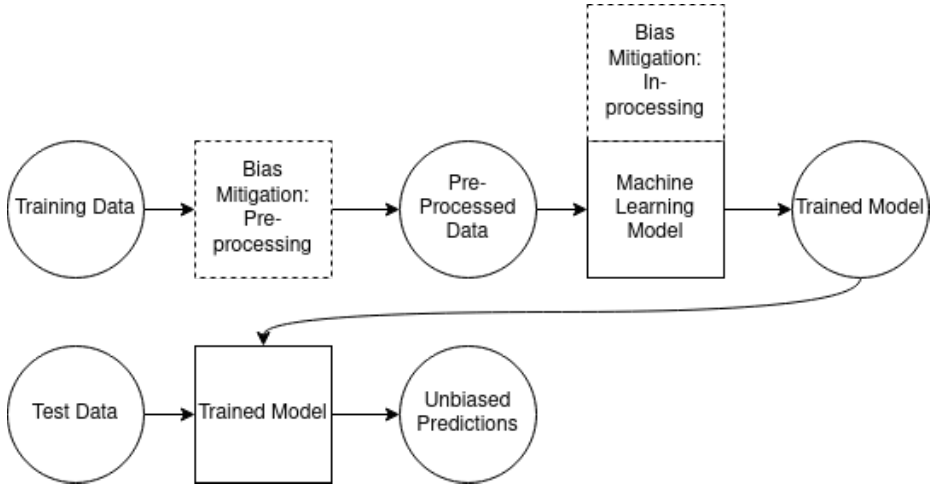
Figure 1. Workflow of data, machine learning models, and bias mitigation techniques used in this